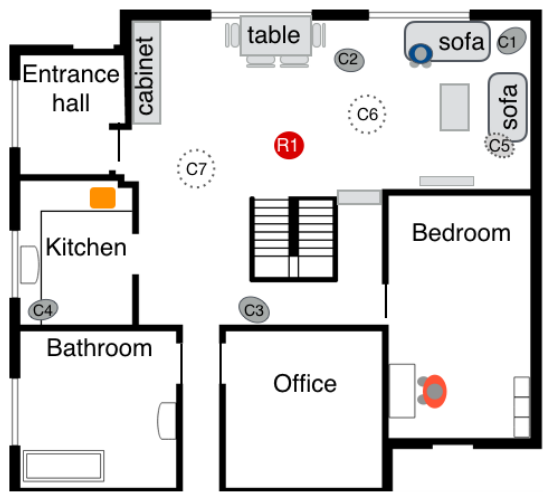
Figure 3: Setup of the experiment: the experimenter is in the bed- room able to see through live cameras C5, C6 and C7 what is hap- pening in the house. The other cameras C1, C2, C3 and C4 were there just for recording purposes. R1 is the robot starting each inter- action in a resting